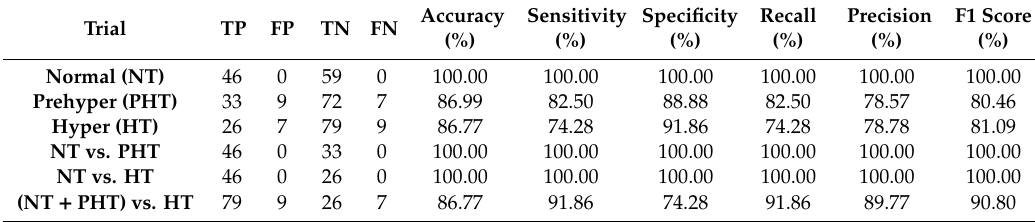
Figure 10. A testing accuracy confusion matrix is used to describe the performance of the classifier in a dataset where the actual values are known. Table 3. Classification performance of KNN algorithm.